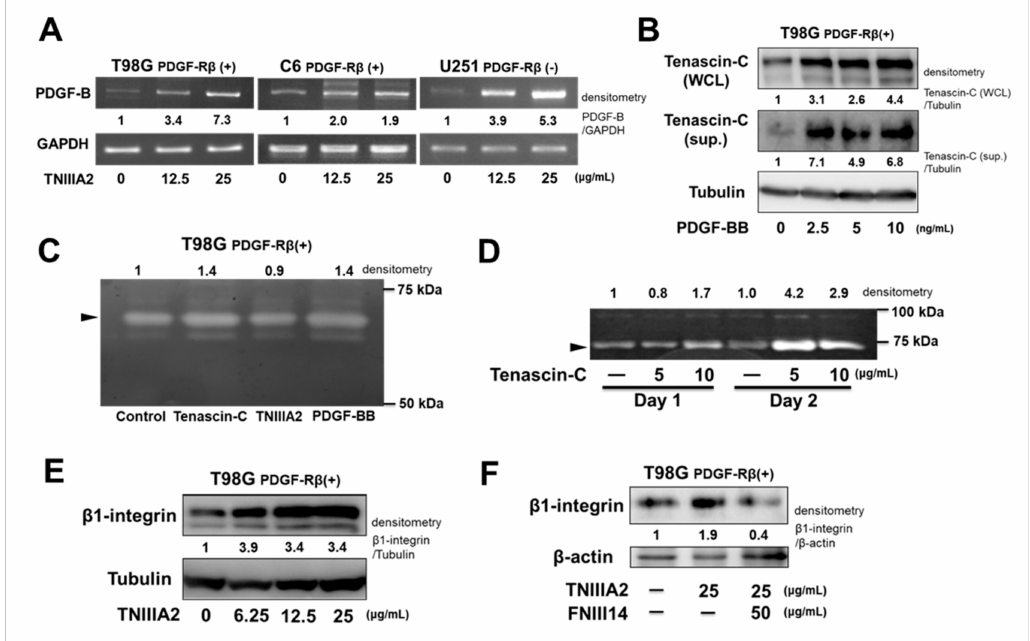
Figure 3. Chain-like increase in PDGF production through the tenascin-C / TNIIIA2 / PDGF / MMP-2 positive spiral loop in GBM cells. ( A ) GBM cells were treated with TNIIIA2. After 24 h, PDGF-B mRNA levels were evaluated by semi-quantitative PCR. ( B ) T98G cells were treated with PDGF-BB for 24 h. Cell supernatants (sups.) and whole cell lysates (WCL) were subjected to western blot analysis. ( C ) and ( D ) Gelatinolytic activity of culture supernatants. In panel ( C ), T98G cells were treated with tenascin-C (10 µ g / mL), TNIIIA2 (25 µ g / mL), or PDGF-BB (10 ng / mL) for 24 h. In panel ( D ), juvenile rat brain-derived cells were treated with tenascin-C at the indicated concentrations. ( E ) and ( F ) Western blotting analysis of the e ff ect of TNIIIA2 on β 1-integrin expression in T98G cells. Cells were treated with TNIIIA2 in the absence or presence of peptide FNIII14 for 24 h. Cell lysates were subjected to western blot